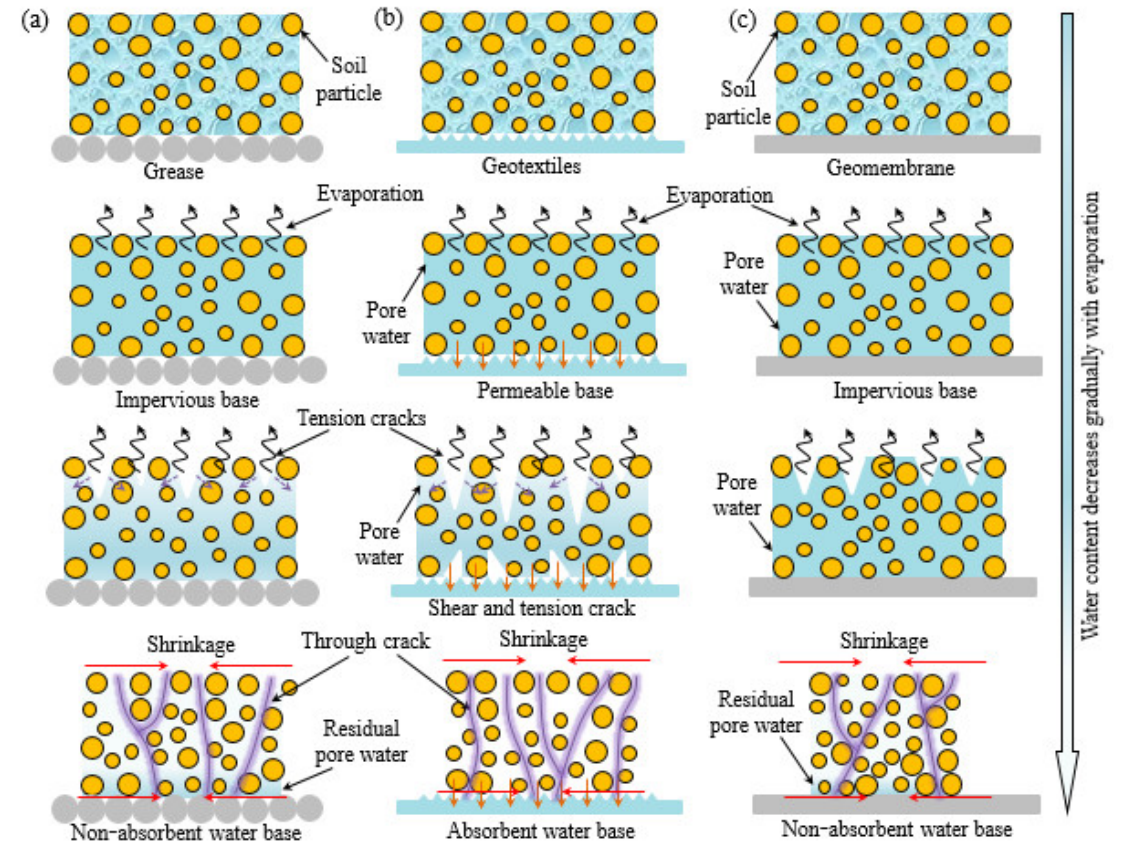
Figure 6. Soil cracking mechanism under different substrate friction and permeability conditions. ( a ) Grease, ( b ) geotextiles , ( c ) geomembranes.